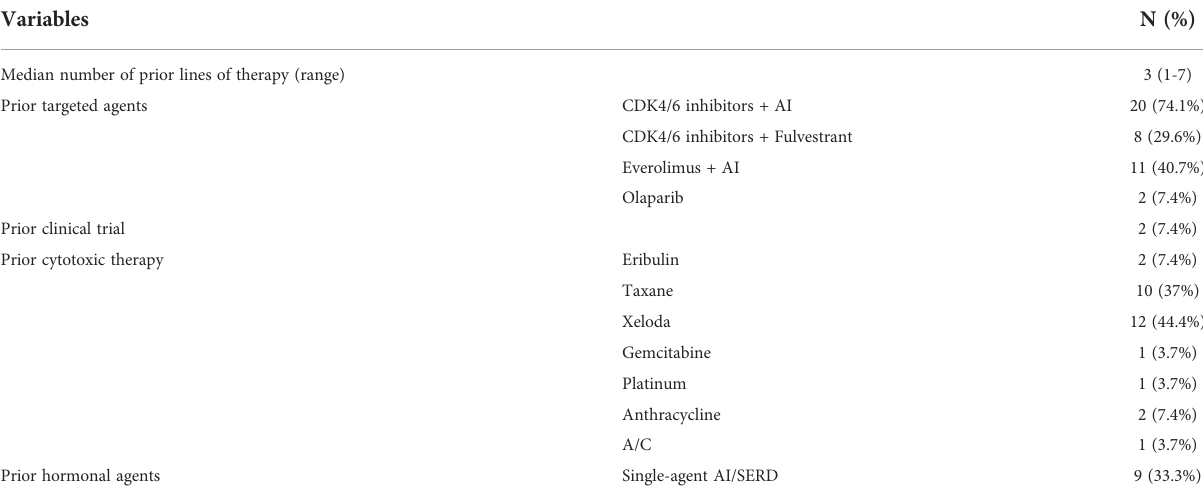
TABLE 2 Prior lines of therapy in the metastatic setting. Variables Median number of prior lines of therapy